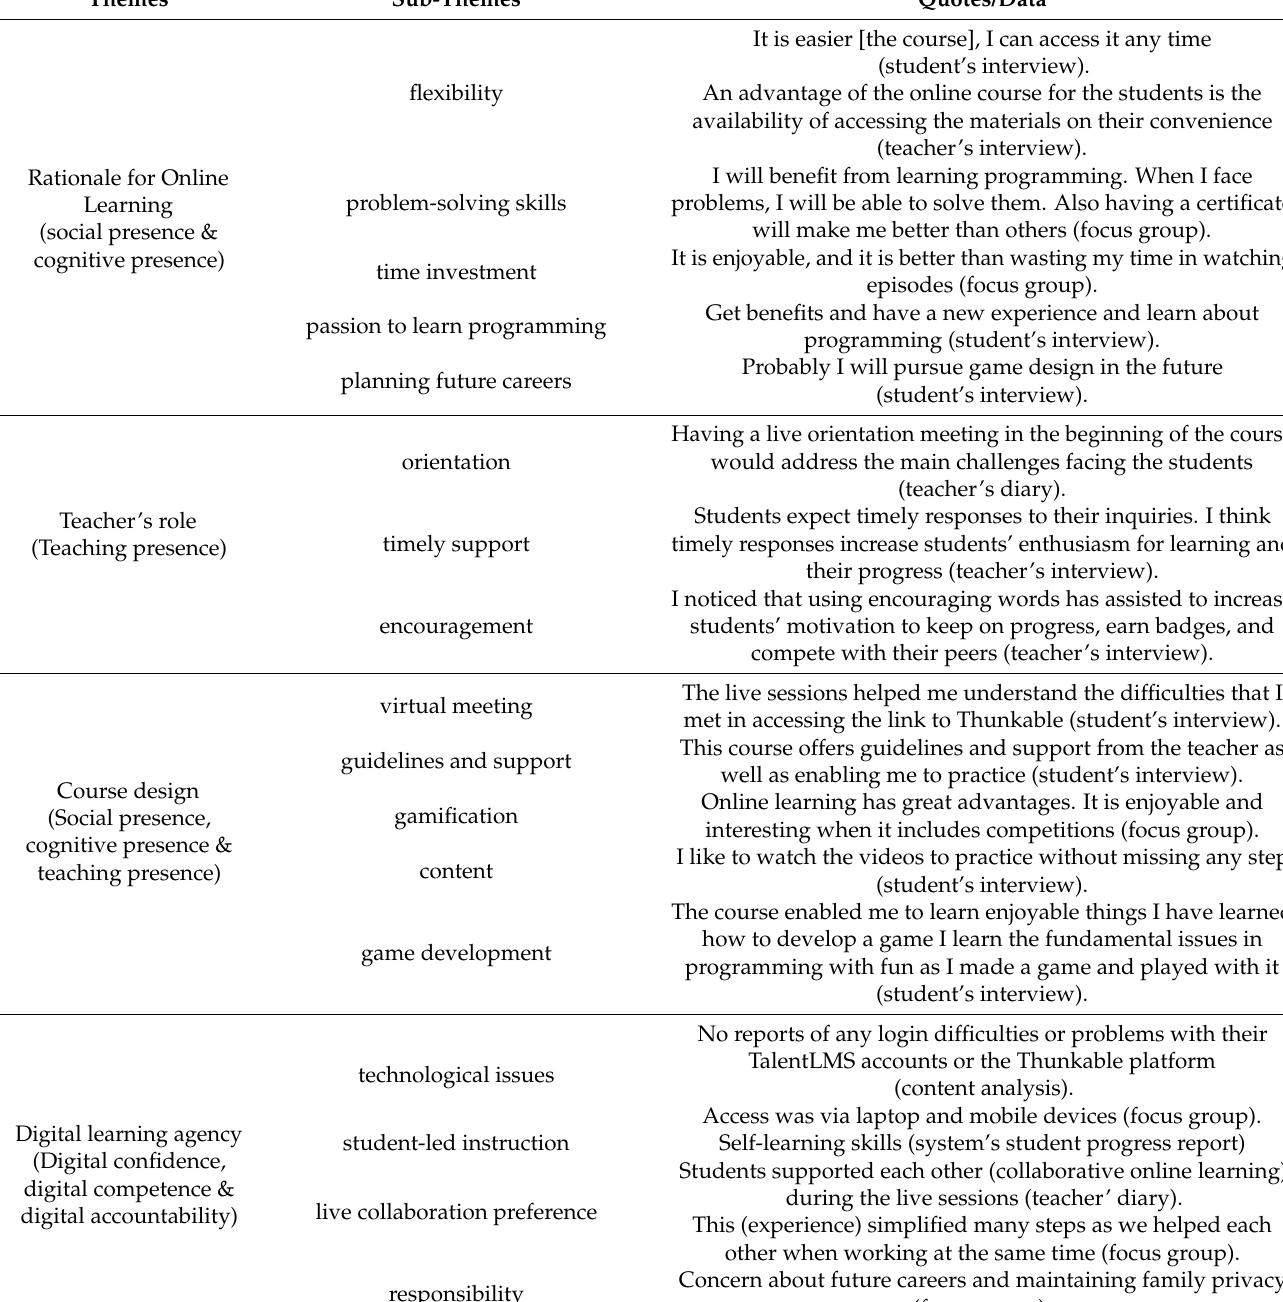
Table 2. Examples of quotes/data reforming the sub-themes and the main